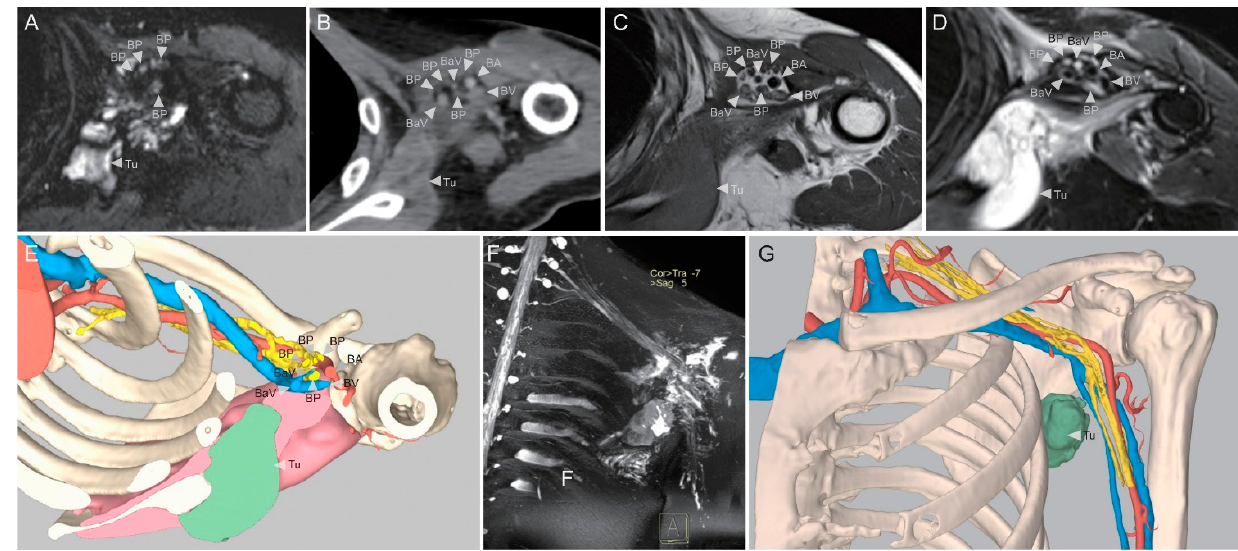
Figure 3. Classic images and their 3D reconstructions in a patient with liposarcoma. ( A ) MR hydrography image; ( B ) CT angiography image; ( C ) T1-weighted MRI; ( D ) T2-weighted MRI; ( E ) multimodality 3D reconstruction image with similar axial views as ( A – D ); ( F ) coronary view of MR hydrography image; ( G ) anterior view image of multimodality 3D reconstruction. Abbreviations: BA, brachial artery; BaV, basilic vein; BV, brachial vein; BP, brachial plexus; Tu, tumour.